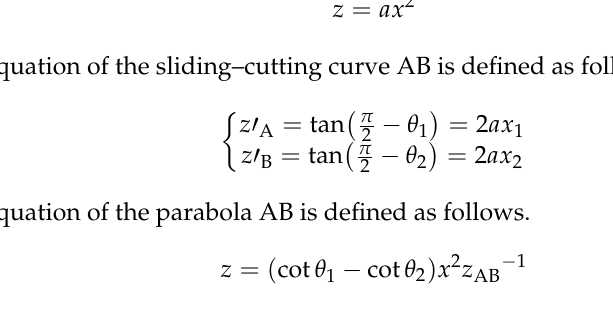
Figure 15. Dynamics analysis of soil particles at the sliding–cutting edge.